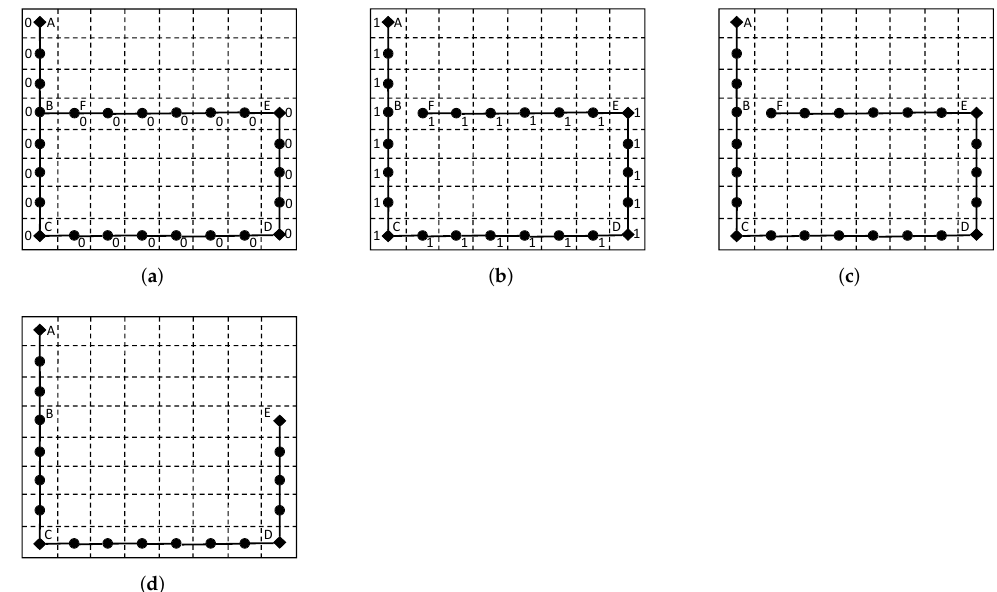
Figure 2. An example of closed loops and redundant nodes being removed based on depth-first search. ( a ) Mark all the net points in the bounding box as unvisited. ( b ) Mark the visited nodes by the DFS technology. ( c , d ) The nodes that have no pin will be removed in the process of backtracking.